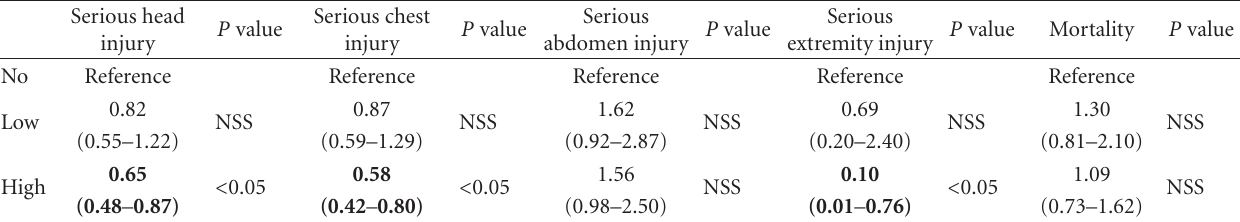
Table 3: Adjusted odds ratios of blood alcohol level for injury severity.